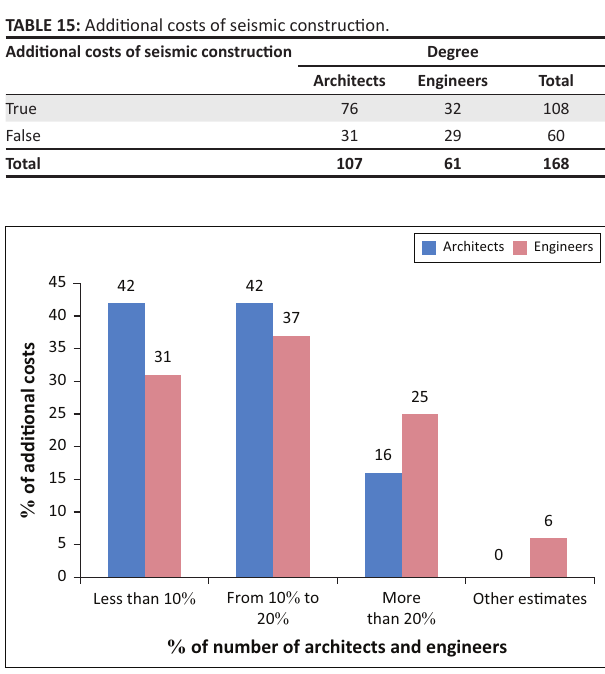
FIGURE 5: Estimation of the additional costs of seismic